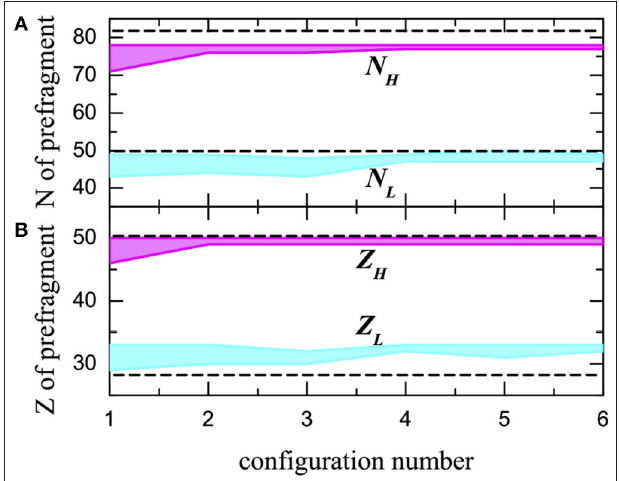
FIGURE 14 | The ranges for the number of localized neutrons (A) and protons (B) for heavier ( N H , Z H ) and lighter ( N L , Z L ) prefragments as a function of the configurations along the EFPs marked in Figure 9B by circles. The magic numbers are marked by horizontal dotted lines.